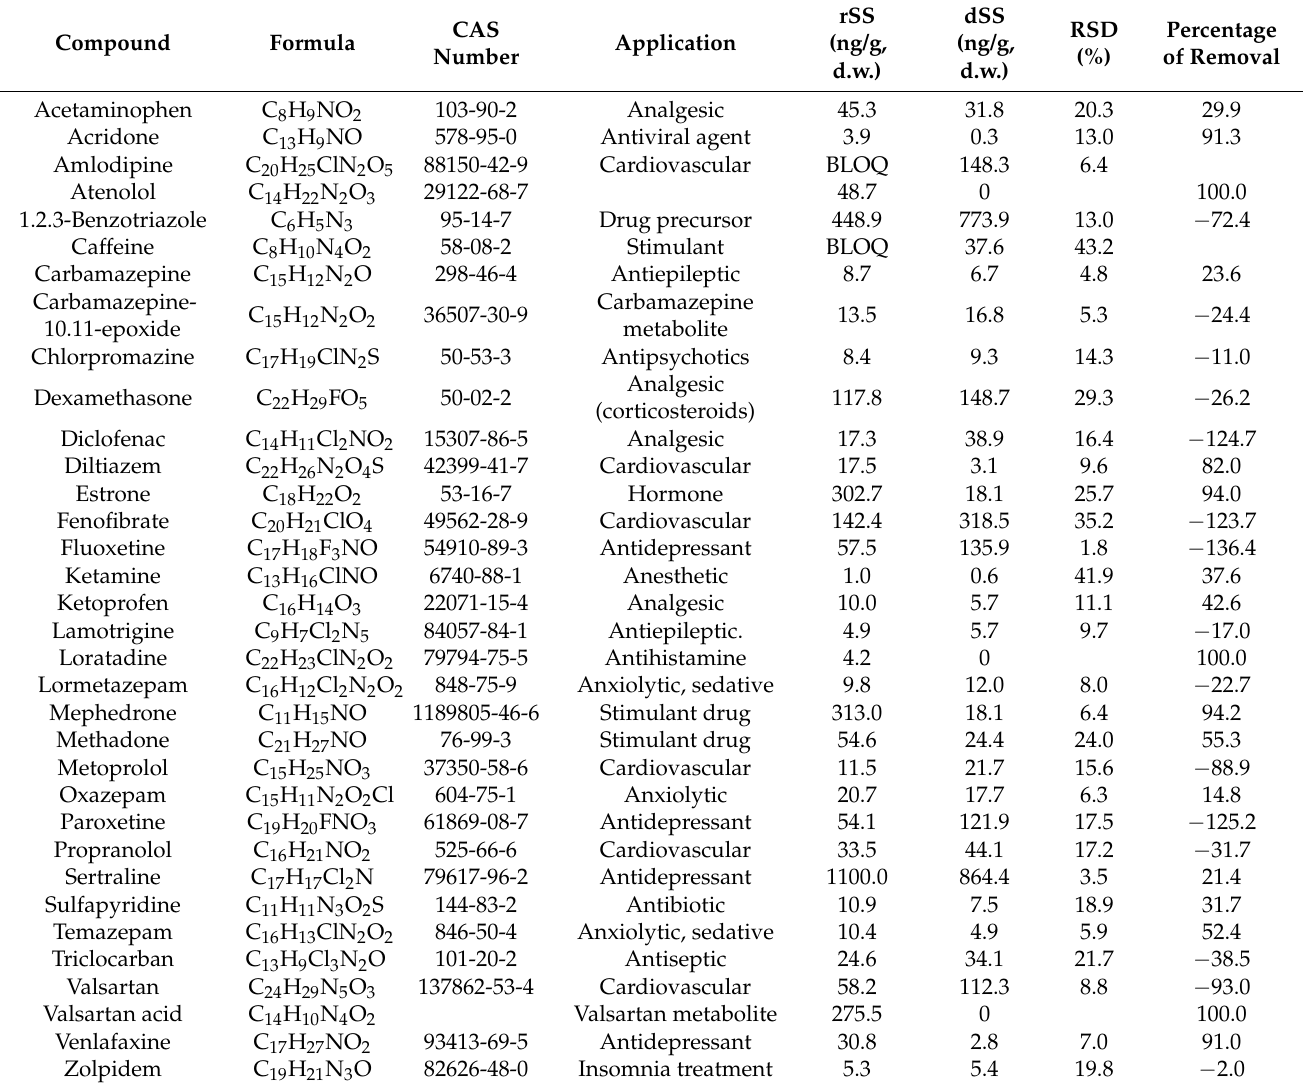
Table 1. Pharmaceutical active compounds content expressed as ng/dw found in Sewage sludge (raw and digested sewage sludge) using